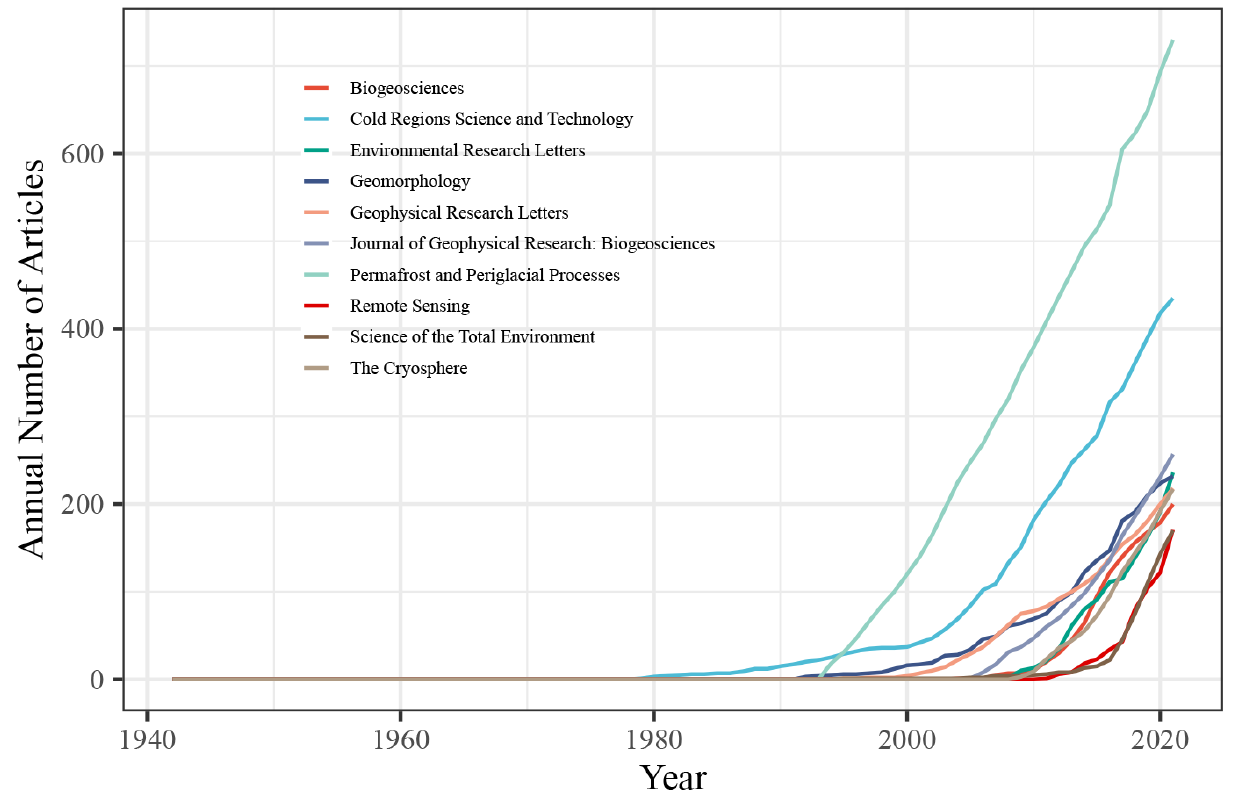
Figure 10. Temporal analysis of the top ten publication sources of permafrost-related research, according to the cumulative publications. Table 6. Top ten journals ranked by the number of local citations in permafrost